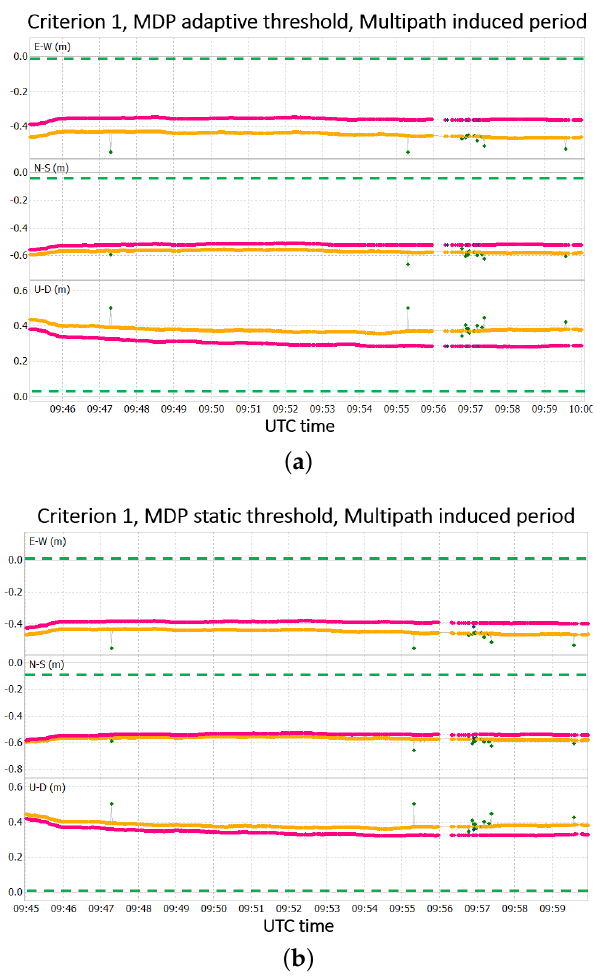
Figure 12. Results obtained after application of the MDP algorithm using criterion 1 with an adaptive MDP threshold ( a ) and static MDP threshold ( b ), referring to the multipath-induced